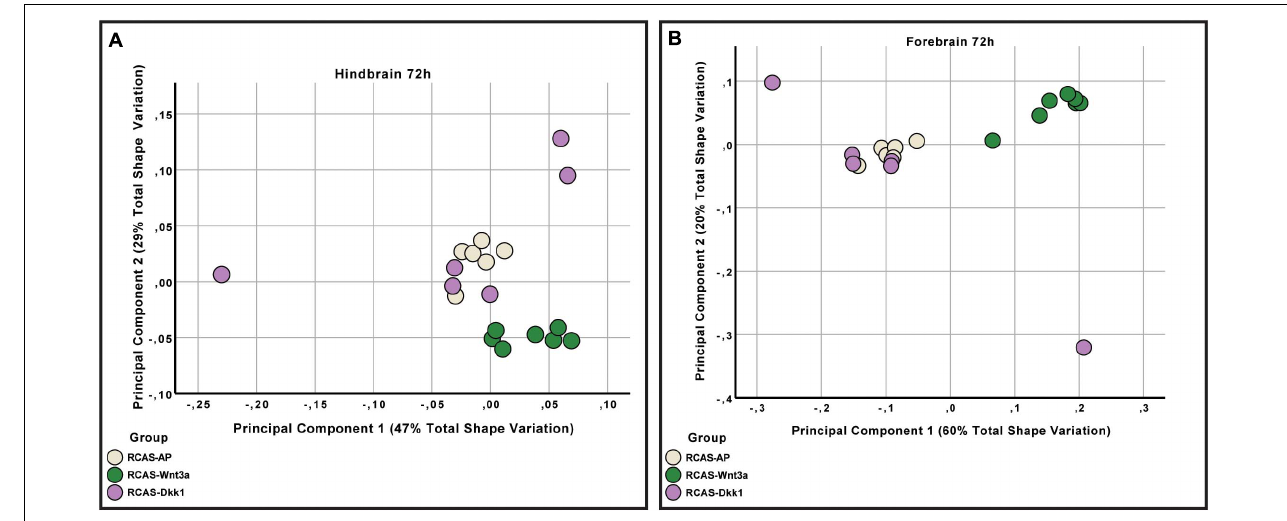
FIGURE 7 | Hindbrain and forebrain shape variation between RCAS-Ap, RCAS- Dkk1 and RCAS- Wnt3a at stage HH22. (A) Biplot of the first two principal components of the hindbrain based on six landmarks. (B) Biplot of the first two principal components of the forebrain based on 11